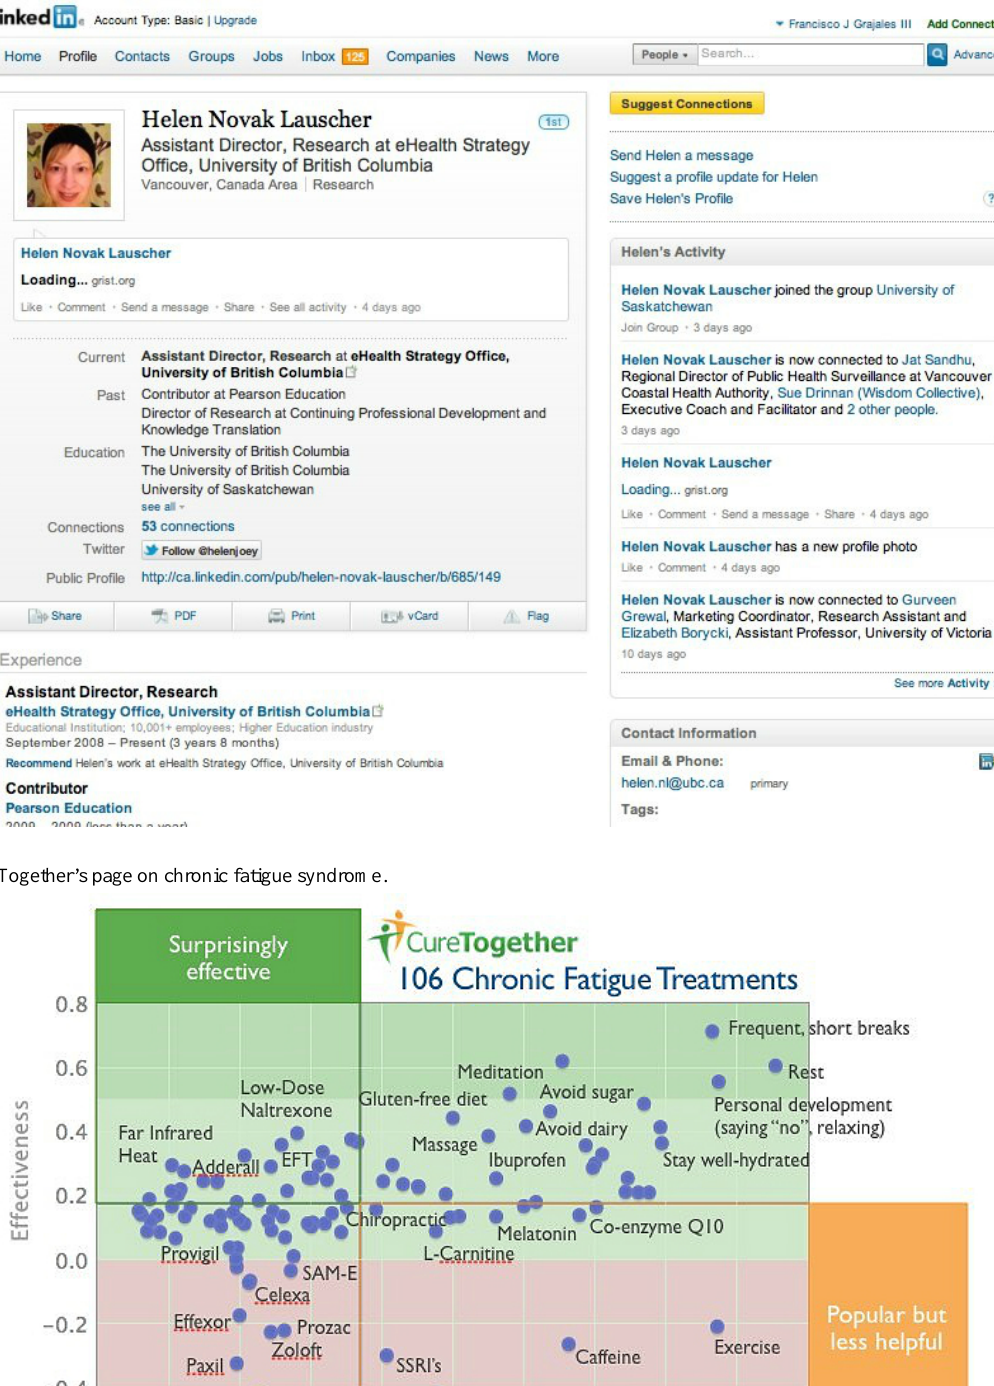
Figure 3. A public profile on LinkedIn.